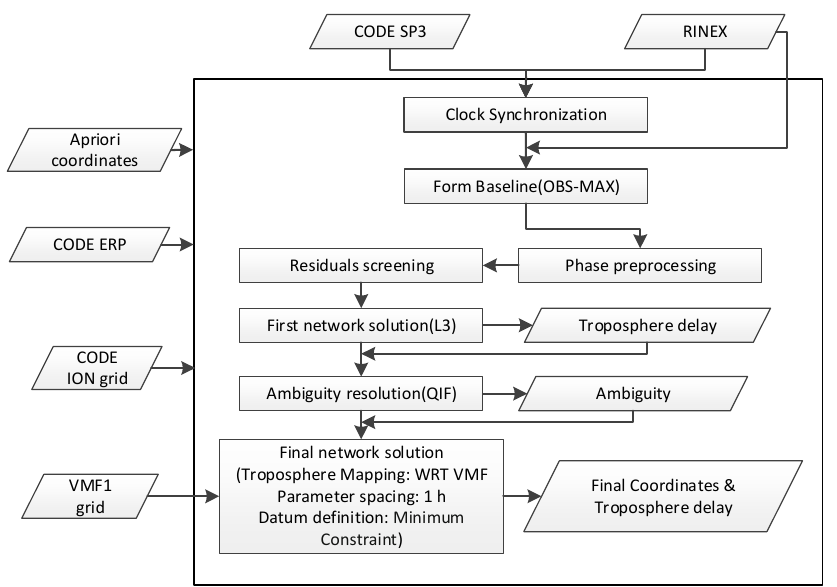
Figure 1. DD network processing scheme.